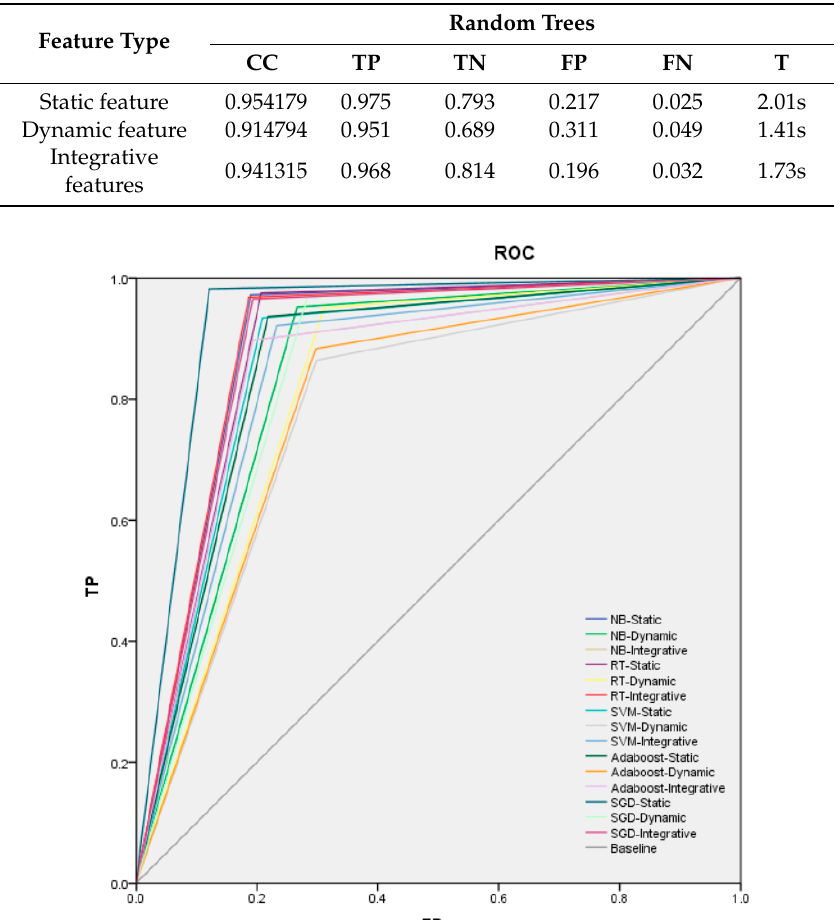
Figure 4. The ROC (Receiver Operating Characteristic curve, ROC) curve of the algorithms. TP (True Positive rate, TP), FP (False Positive, FP), NB (Naive Bayes, NB), SGD (Stochastic Gradient Descent,